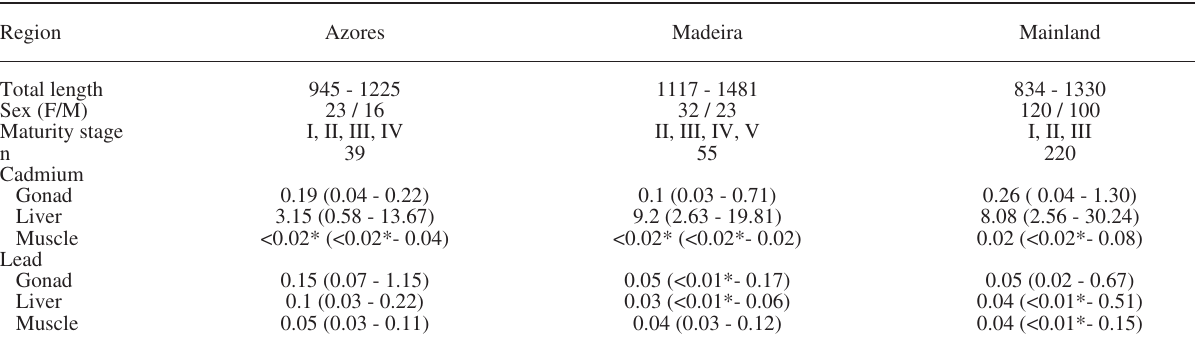
Table 2. – summary of the descriptive statistics of the cadmium and lead analyses for the three tissues from the azores, Madeira and Main- land: range of total length (mm), number of specimens by sex, maturity stages available for each geographic region; number of specimens sampled (n) and median and range of lead and cadmium concentration (mg/kg